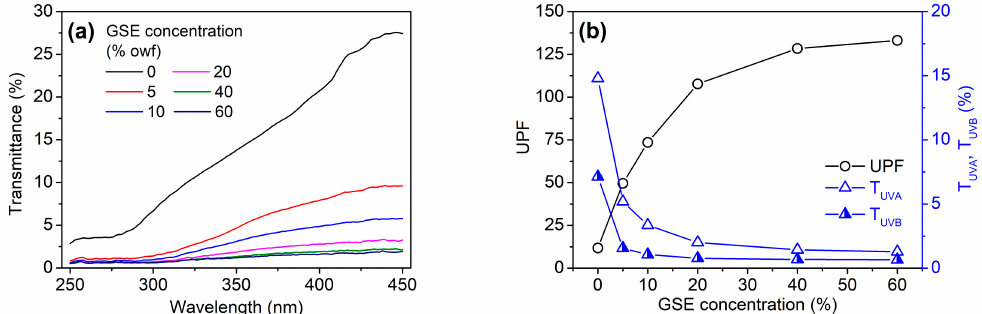
Figure 8. UV transmittance curves ( a ) as well as UPF and UVA / UVB transmittance ( b ) of cotton fabrics dyed with GSE at various concentrations.